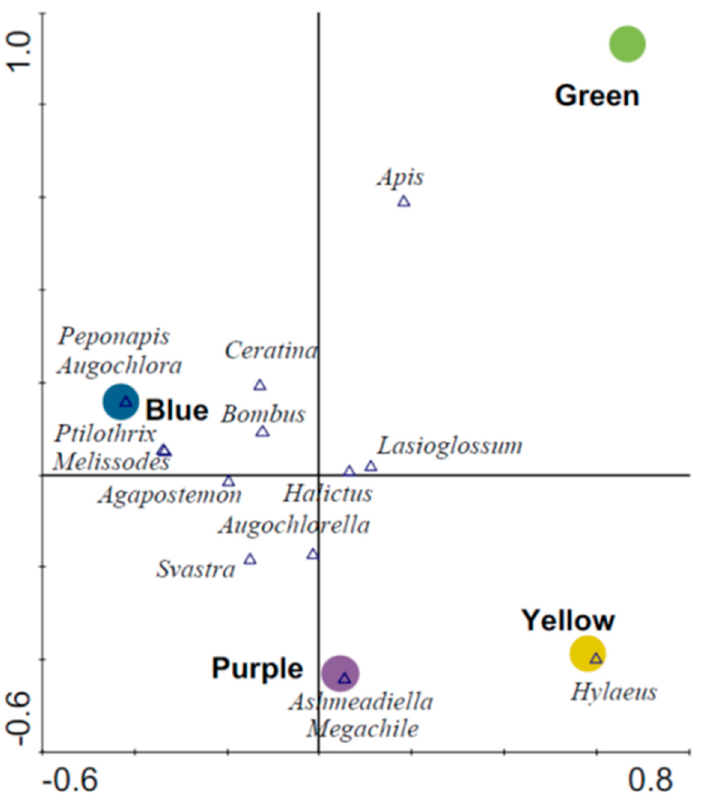
Figure 4. Redundancy analysis (RDA) biplot showing the association of wild bee species and different colored pan traps. pan